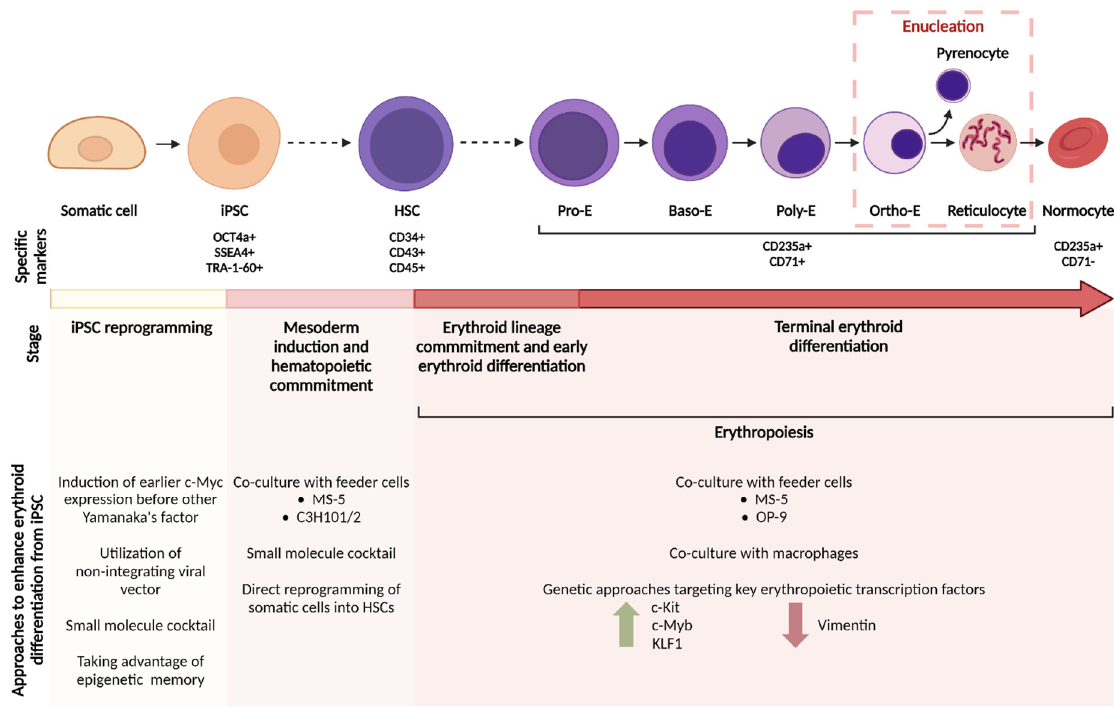
Figure 1. Approaches to enhance erythroid differentiation from iPSC. The production of iPSC-derived erythrocytes involves multiple differentiation steps, from mesoderm induction, hematopoietic commitment, erythroid lineage commitment to erythroid differentiation, each identified by specific sets of markers. Different approaches involving genetic modifica- tions or external factors are needed to improve erythropoiesis at each stage. iPSC, induced pluripotent stem cell; HSC, hematopoietic stem cell; Pro-E, proerythroblast; Baso-E, basophilic erythroblast; Poly-E, polychromatic erythroblast; Ortho-E, orthochromatic erythroblast. Created with